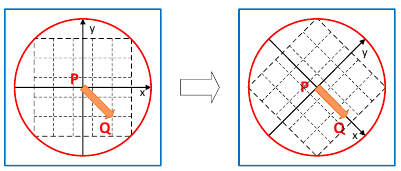
Figure 3. Schematic diagram of the rotation of the coordinate axes in the main direction